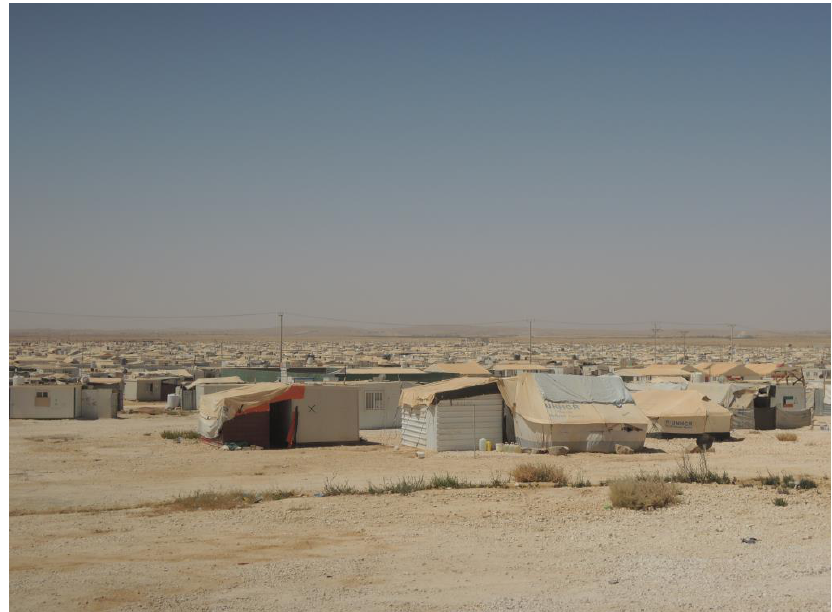
Figure 1. Zaatari Camp (Source: Author 2015).